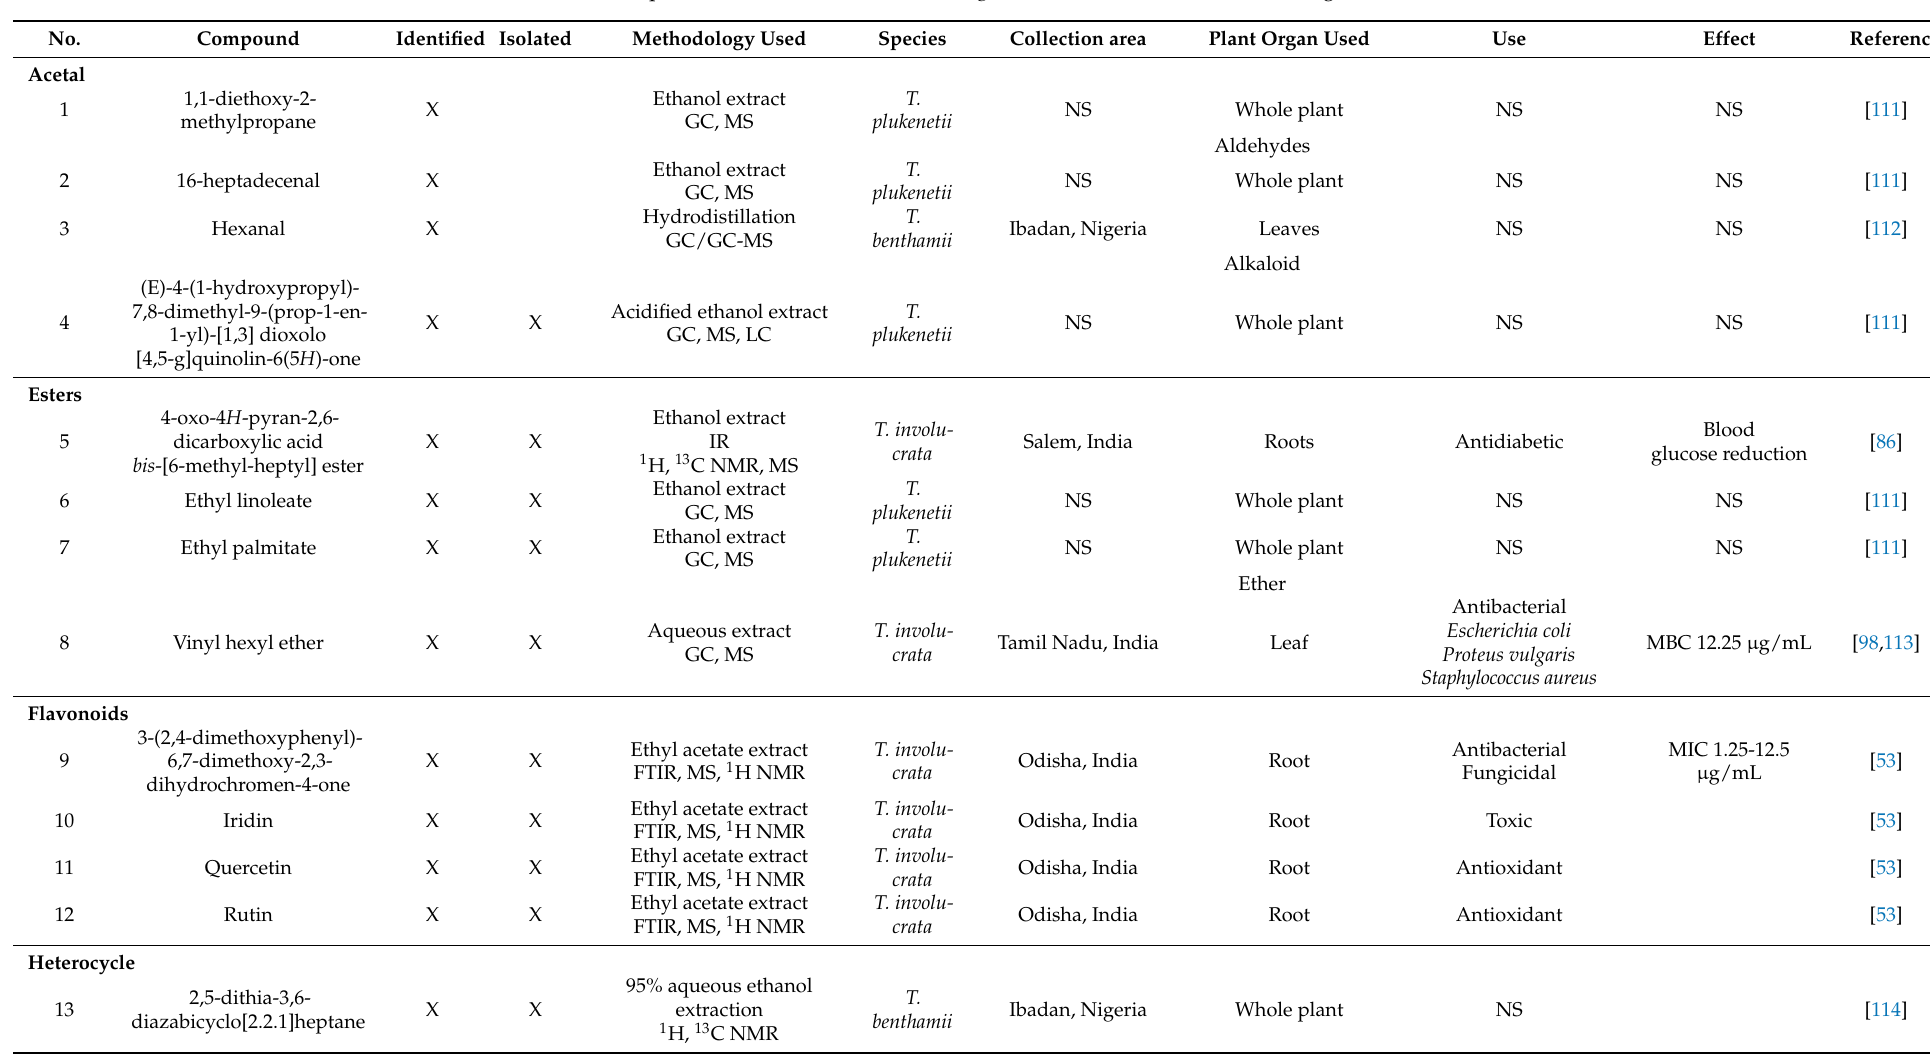
Table 4. Compounds isolated/identified in Tragia extracts and oils and their biological